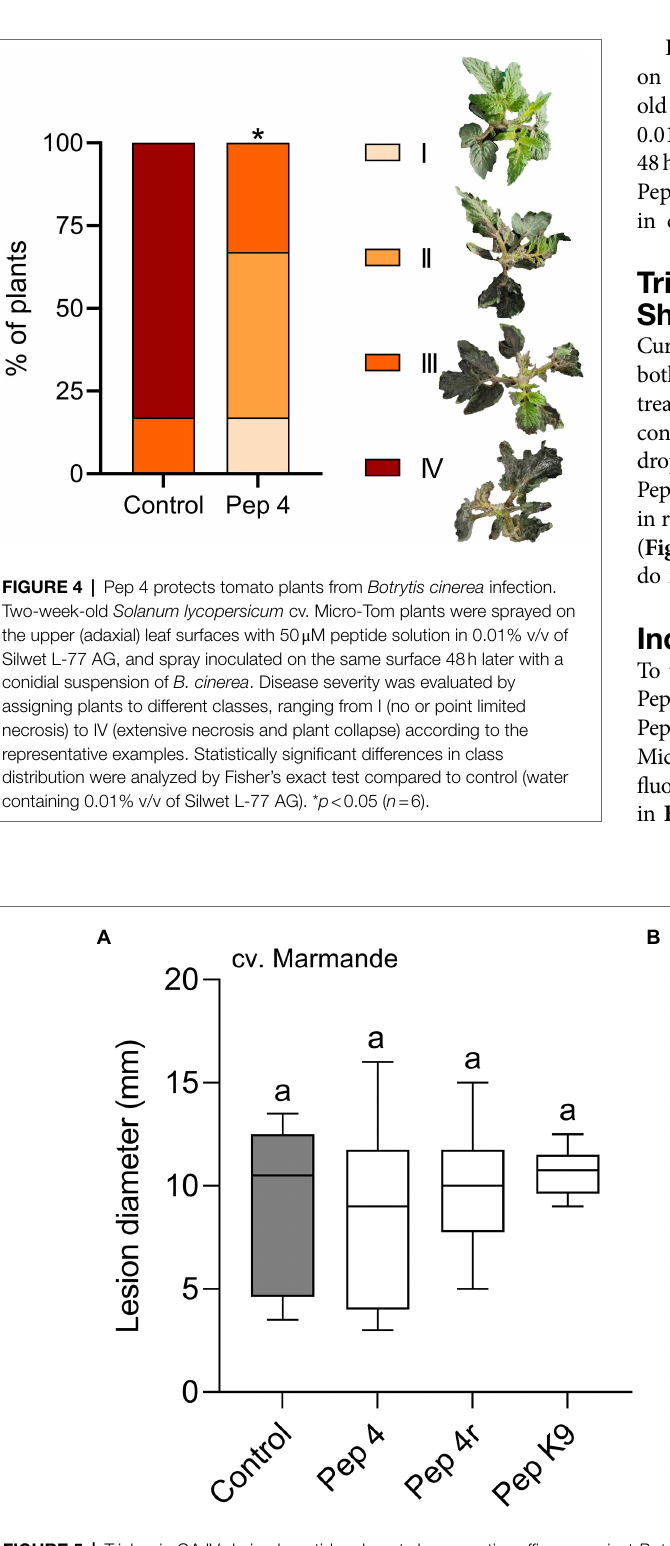
FIGURE 5 | Trichogin GA IV-derived peptides do not show curative efficacy against Botrytis cinerea infection. The leaf abaxial surface of Solanum lycopersicum cv. Marmande (A) or Micro-Tom (B) was first drop inoculated with a conidial suspension of B. cinerea , and, 24 h later, was sprayed with 50 μ M peptide solution in water containing 0.01% v/v of Silwet L-77 AG. Lesion diameters were measured 3 days after pathogen inoculation. Control leaves were treated with water containing 0.01% v/v of Silwet L-77. Values from 12 to 13 (A) or 13 to 15 (B) biological replicates are reported as Tukey boxplots. Data were analyzed by one-way ANOVA with Tukey–Kramer post-test ( p < 0.05). Statistically significant differences are shown by different